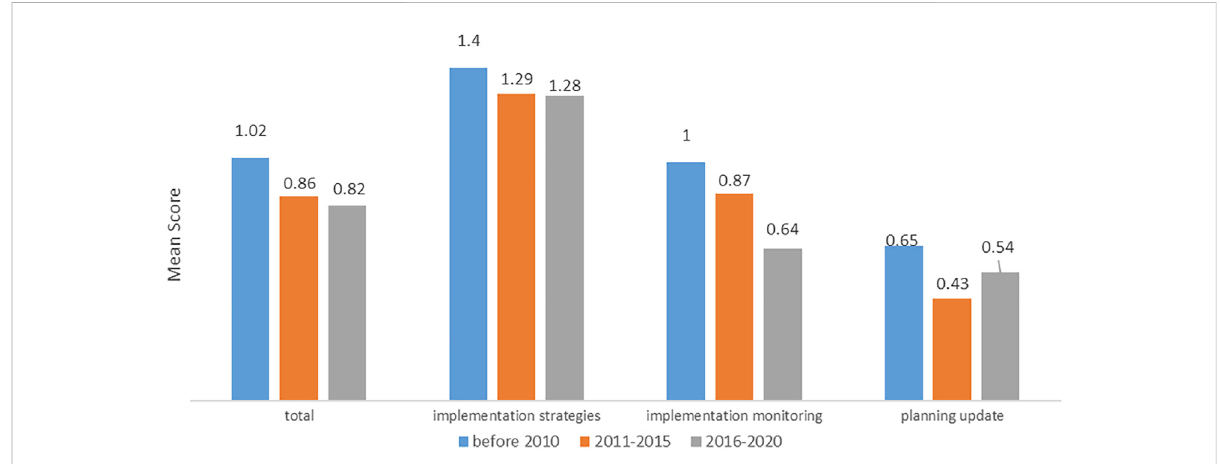
FIGURE 7 Scores of indicator items under the dimension “ planning implementation, ” by time